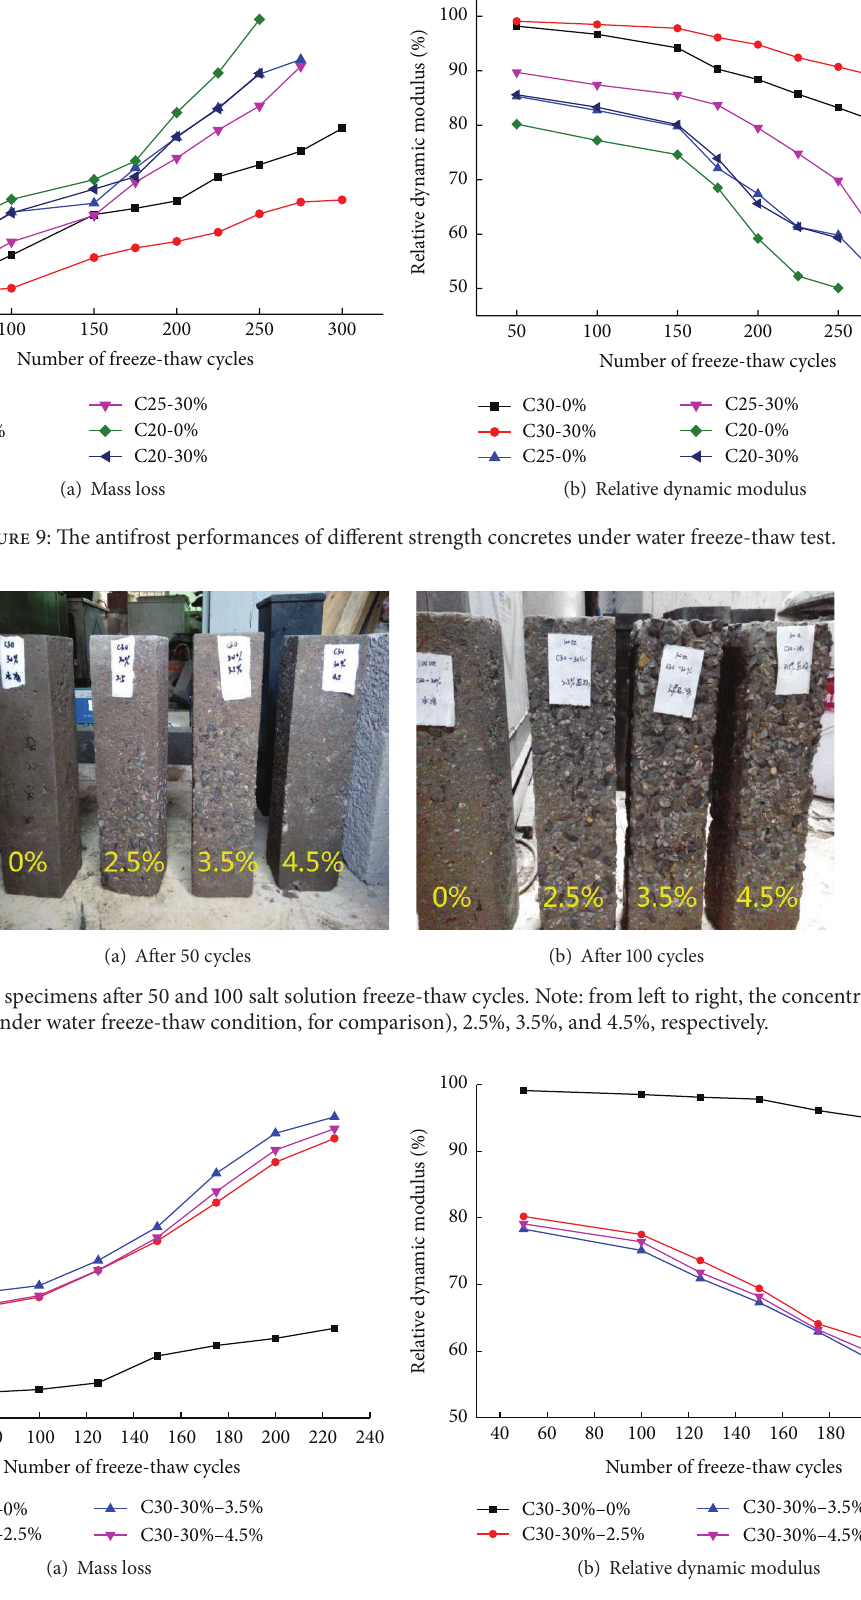
Figure 11: The antifrost performance of C30-30% concrete under NaCl solution freeze-thaw